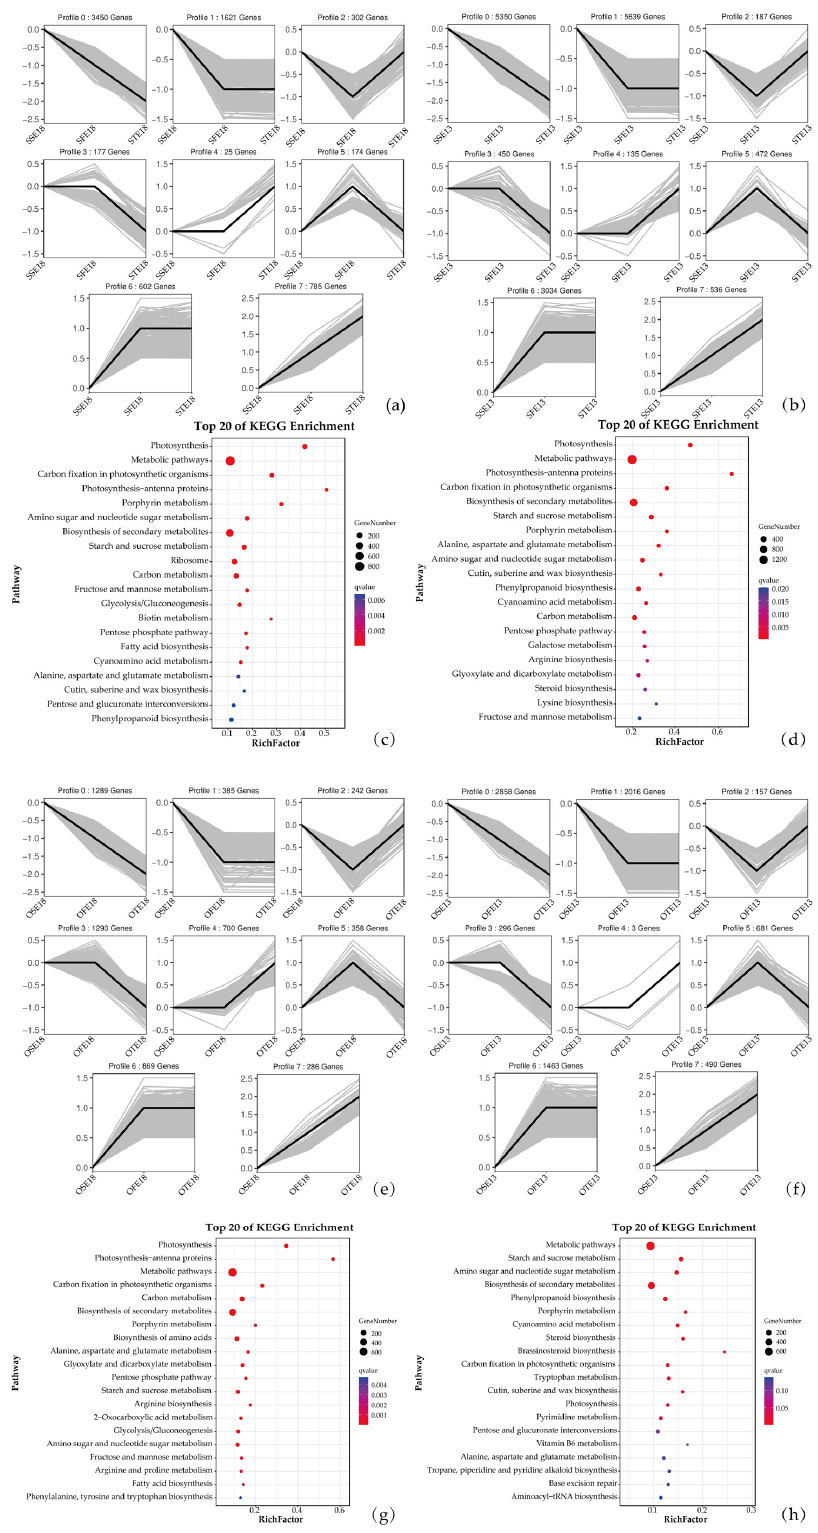
Figure 4. Expression profiles for differentially expressed genes for different nighttime temperature treatments with annotations from the Kyoto Encyclopedia of Genes and Genomes. ( a , b , e , f ) eight representative expression patterns were screened for eight clusters; ( c , d , g , h ) enrichment scatter diagram. Black lines were deemed to the trends of genes expression of STSL and WTSL at different nighttime